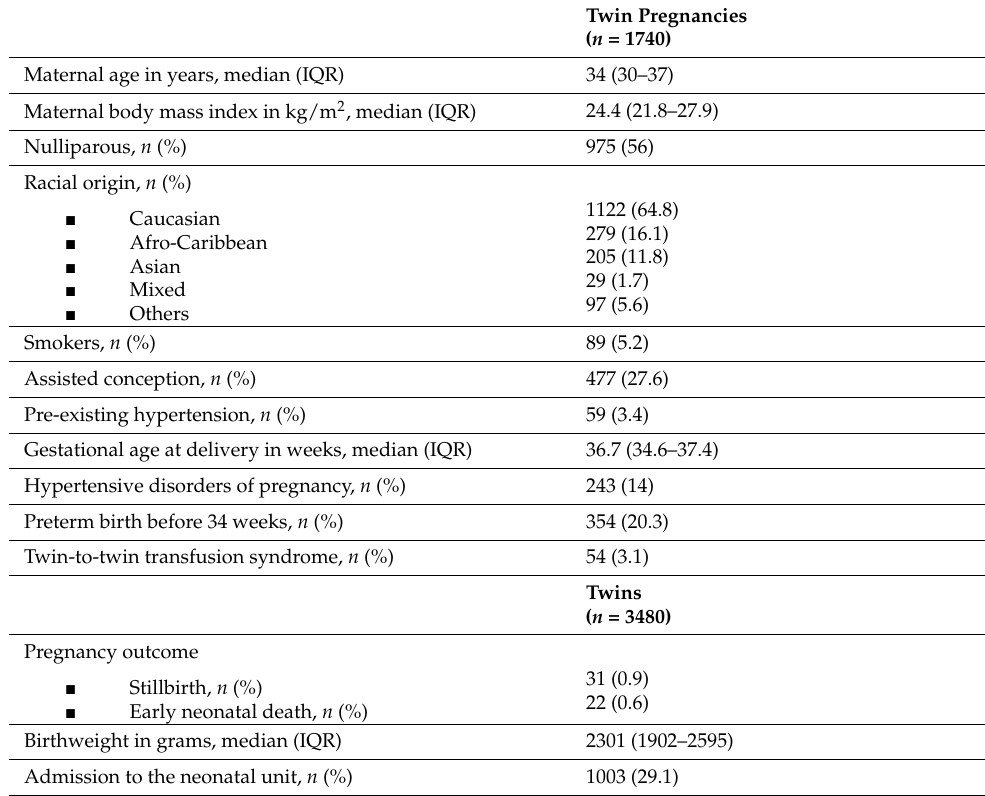
Table 1. Baseline demographics and pregnancy characteristics of the study